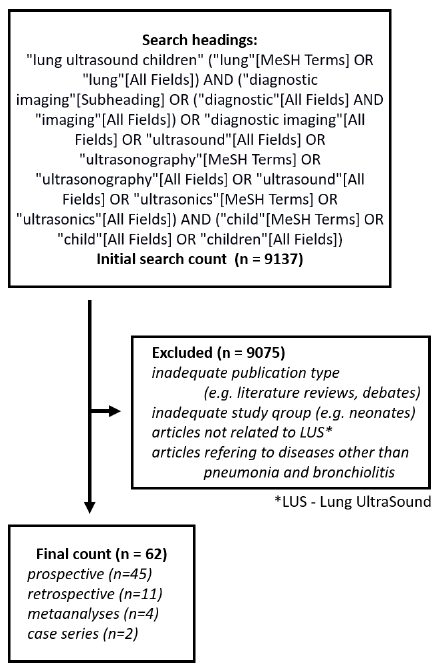
Figure1. PRISMA(PreferredReportingItemsforSystematicReviewsandMeta-Analyses)flowdiagram. Figure 1. PRISMA (Preferred Reporting Items for Systematic Reviews and Meta-Analyses) flow diagram.